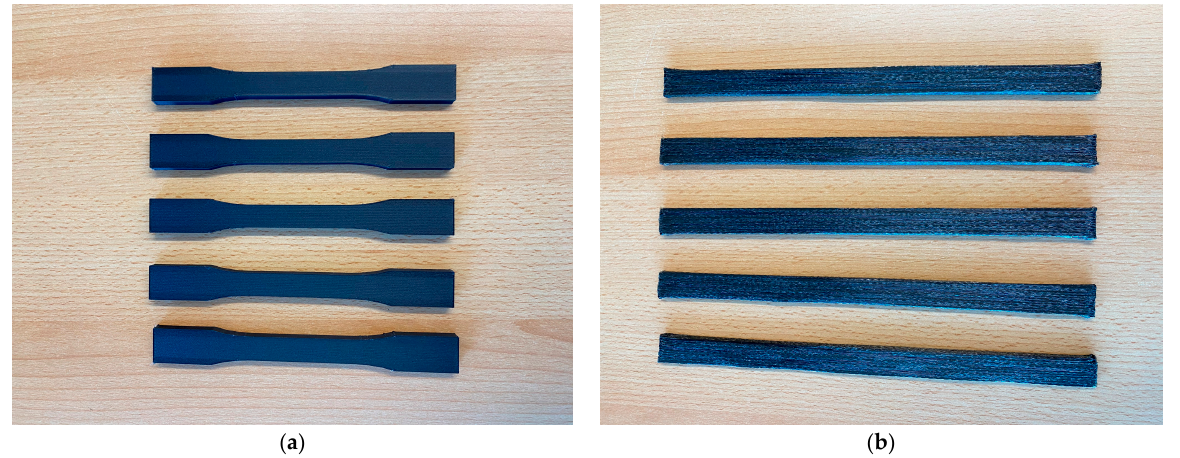
Figure 3. ( a ) Additively manufactured chopped FRP specimens, 0°; ( b ) additively manufactured continuous FRP specimens, 0°.